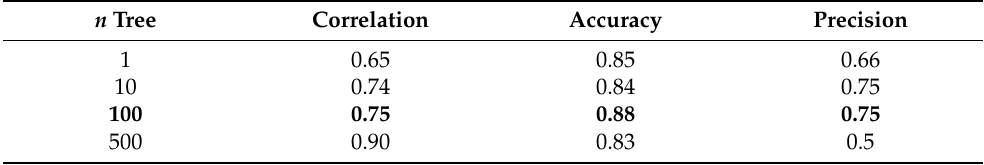
Table 3. Best correlation, accuracy and precision values obtained setting 1, 10, 100 and 500 decisional trees in RF–RFE–CV process.